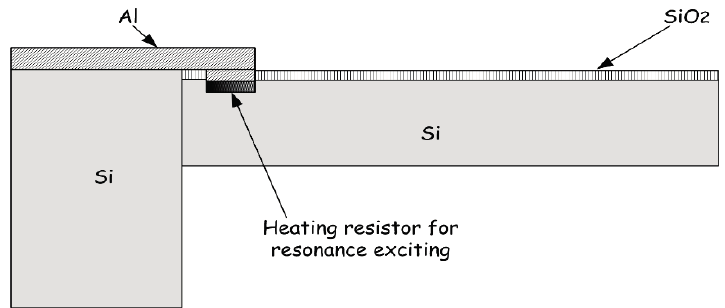
Figure 2. Cross-sectional schematic of a silicon micro-cantilever, in which a resonance exciting heater is integrated. Reprinted with permission from [48].